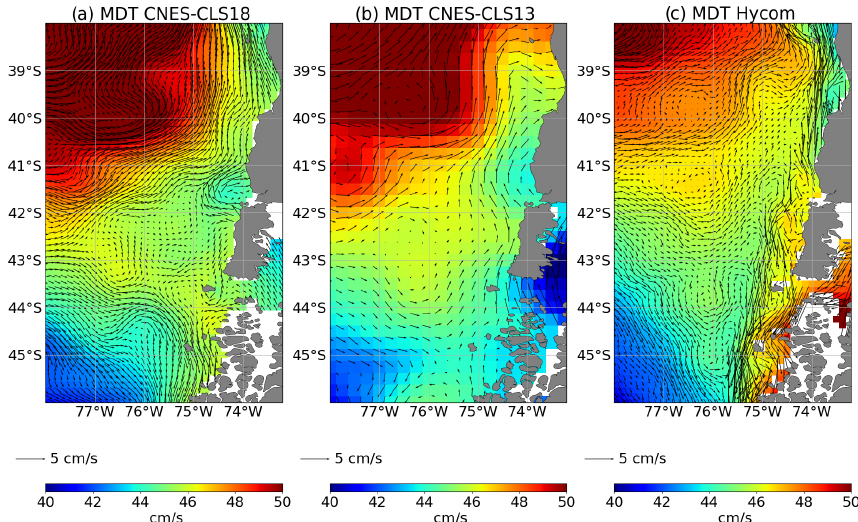
Figure 13. MDT and associated mean geostrophic current along the south Chilean coast from the MDT CNES-CLS13, MDT CNES-CLS18 and the numerical model HYCOM interpolated on the MDT CNES-CLS18 grid (1 / 8 ◦